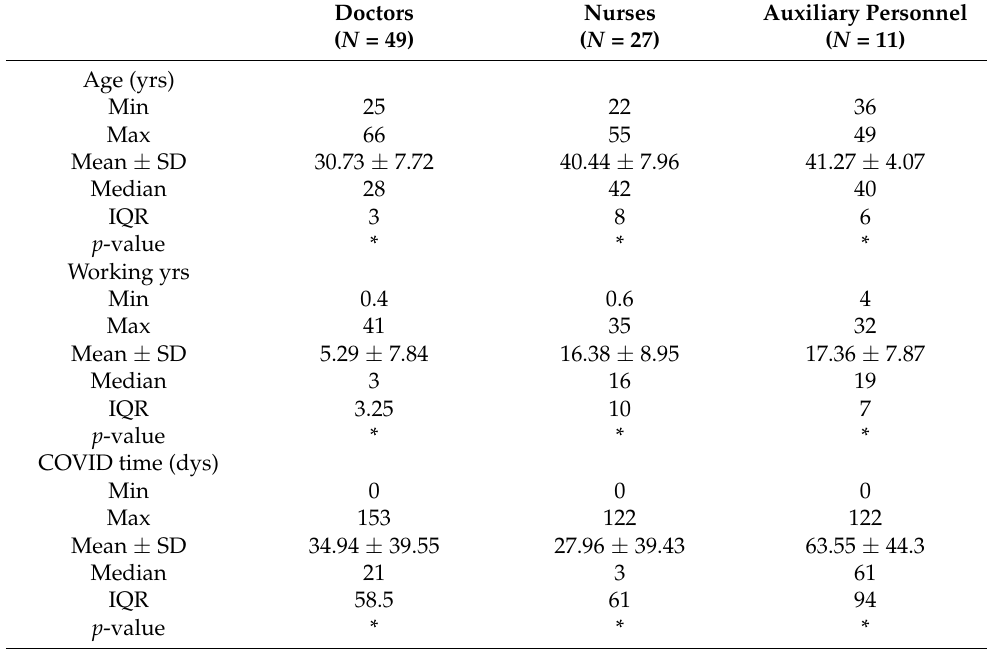
Table 1. Descriptive statistics of age, working years, and COVID time for the studied groups. YRS- years Min—Minimum; Max—Maximum; SD—Standard Deviation; IQR—Inter Quartile Range; *— statistically significant.